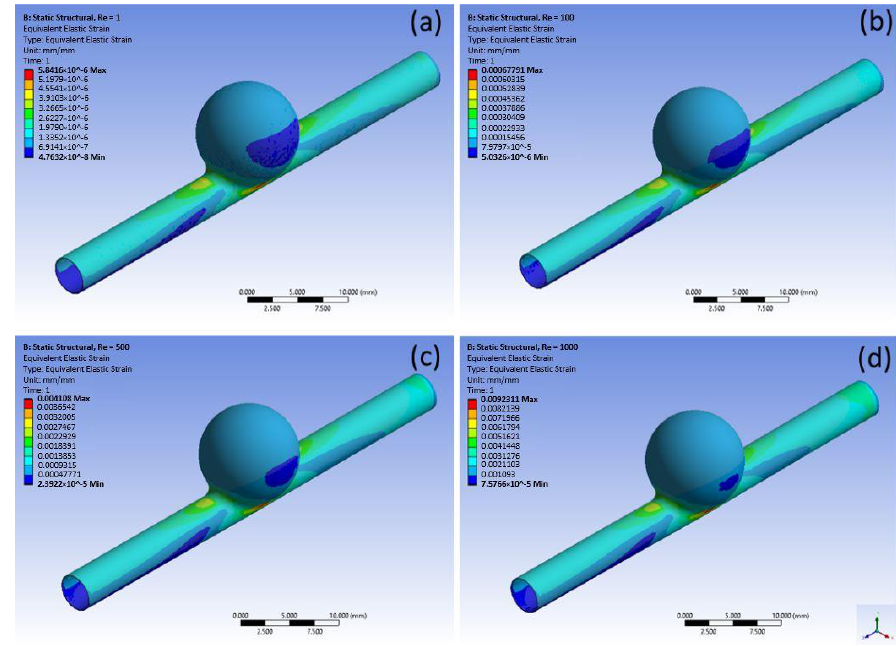
Figure 14. Equivalent Elastic Strain: ( a ) Re=1; ( b ) Re=100; ( c ) Re=500; ( d ) Re=1000.